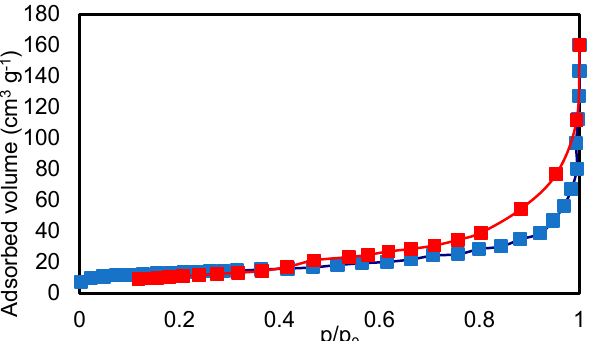
Figure 3. Adsorption-desorption isotherm of the zeolite sample using the BET method. Adsorption data: blue color. Desorption data: red color.